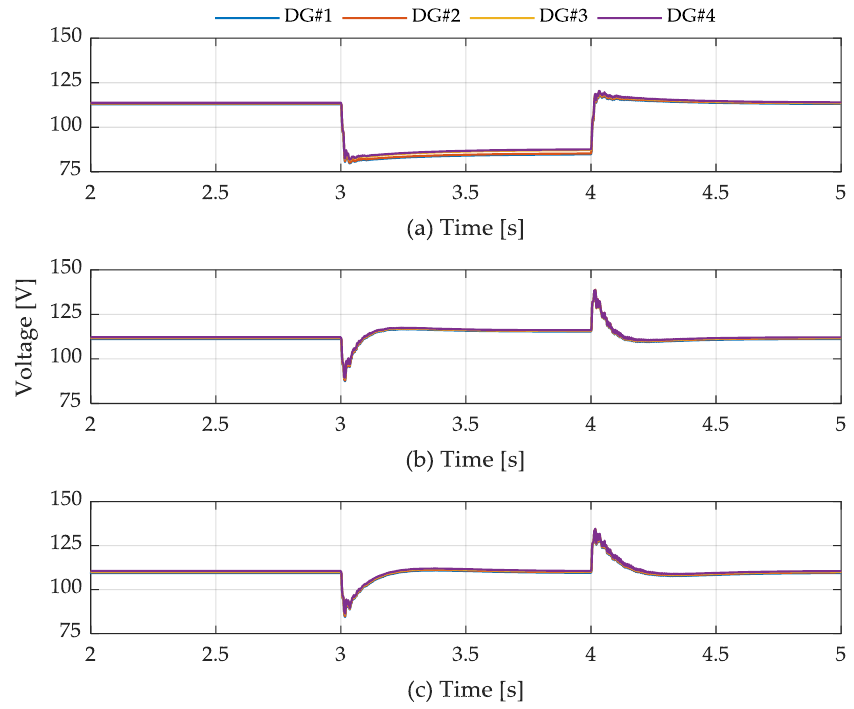
Figure 7. Output voltage of each distributed generators (DG): ( a ) without LVRT; ( b ) centralized method; ( c ) proposed method.